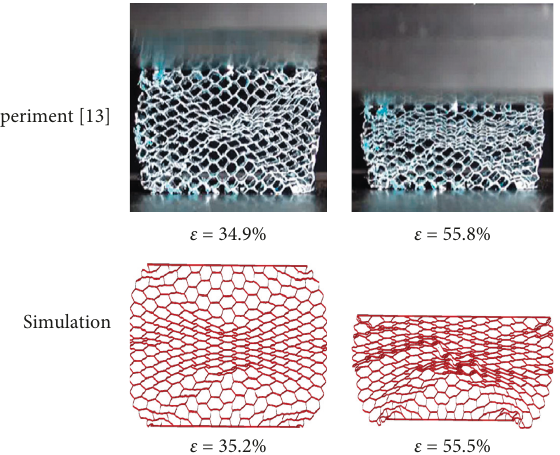
Figure 3: Comparison of deformation